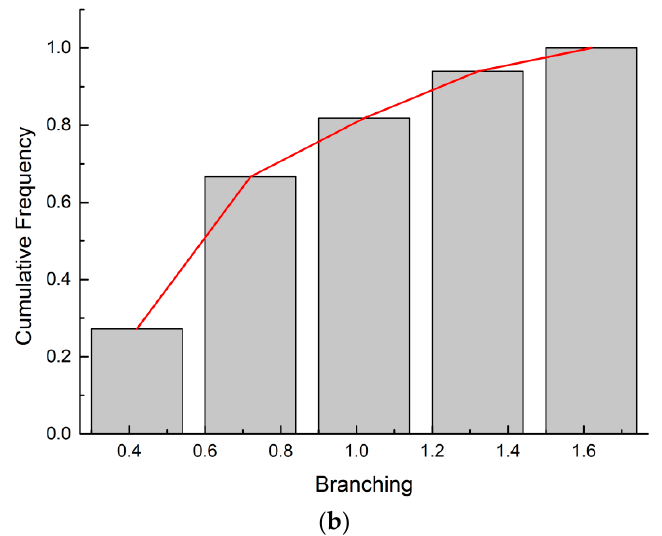
Figure 9. Branching frequency histogram of reactivated microcracks. ( a ) Relative frequency. ( b ) Cu- mulative frequency.